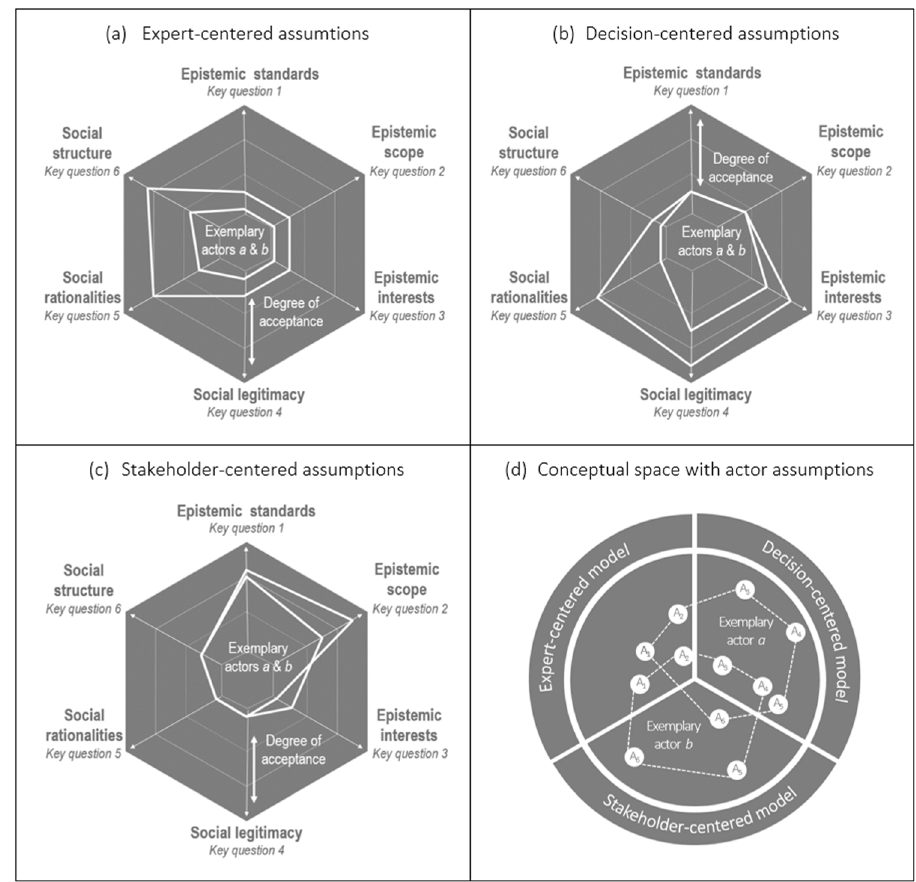
Fig. 3 Mapping of actor assumptions in the conceptual space. Assumptions are identi fi ed by determining the actors ’ acceptance of each taxonomic SSIM in each thematic dimension, e.g. on a Likert scale ( a – c ). Convergences and differences between actors are assessed by comparing the position of the actors ’ non-taxonomic SSIMs in the conceptual